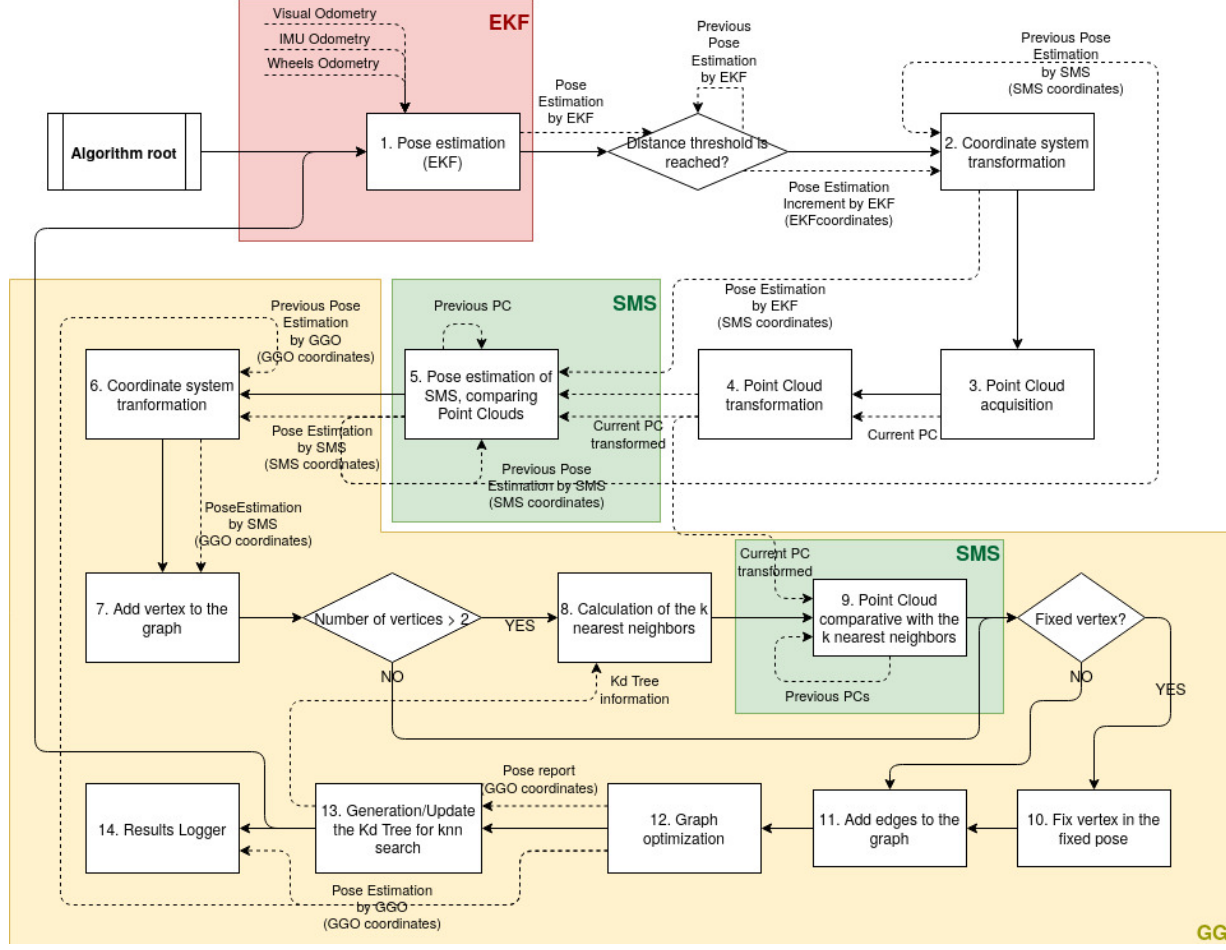
Figure 3. Flowchart of the graph